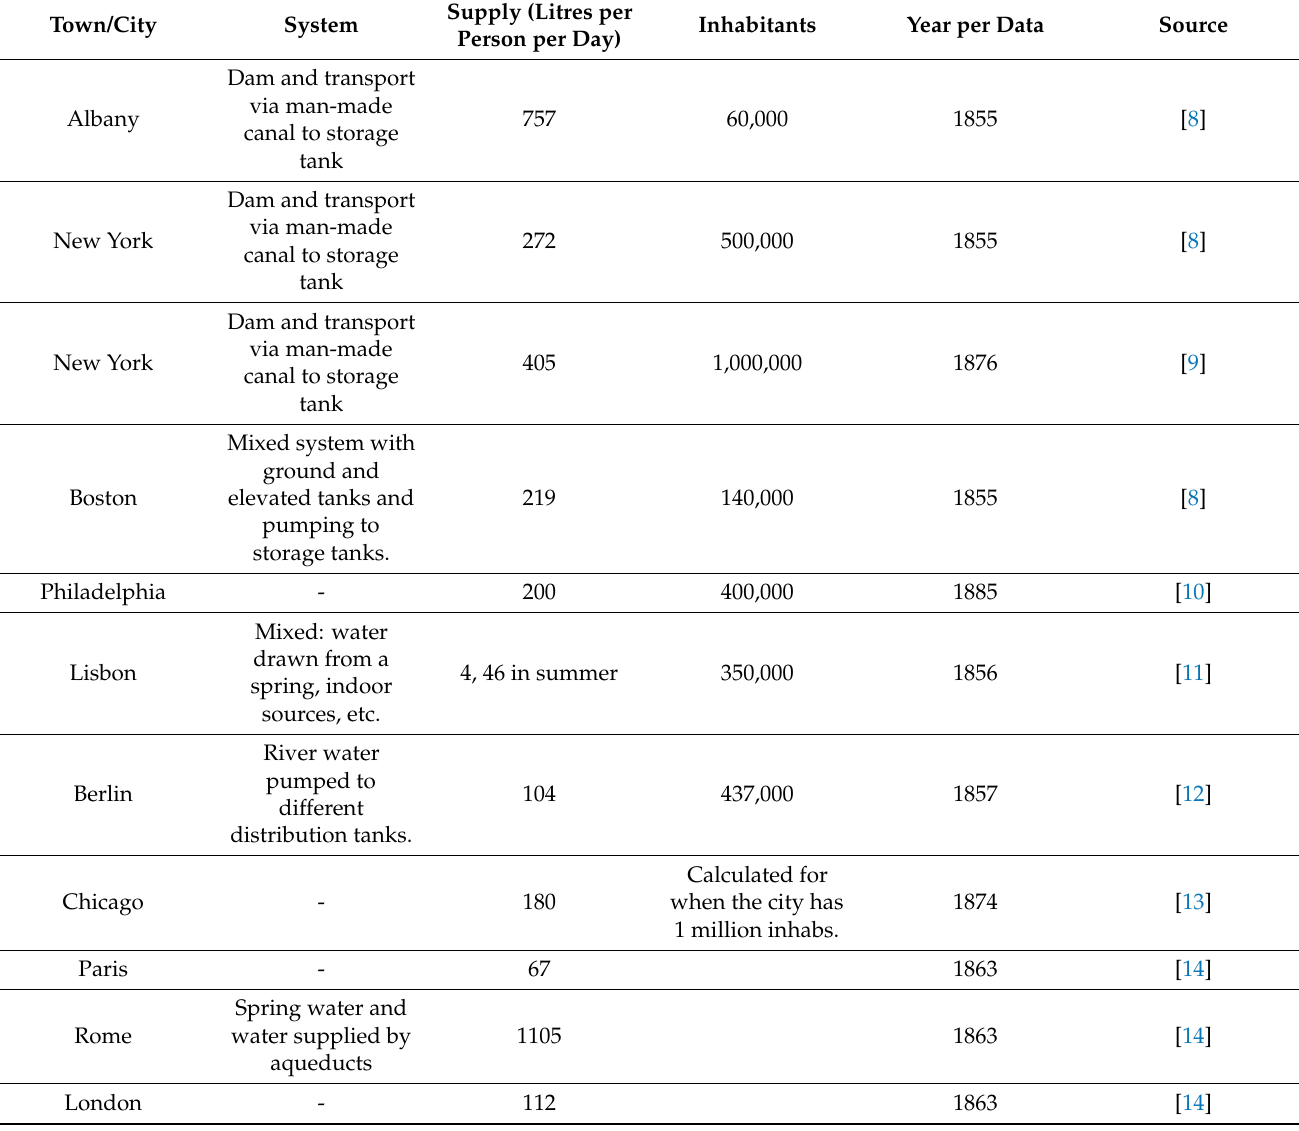
Table 1. Some supply and systems data from different towns and cities in Europe and America. Authors’ own creation from